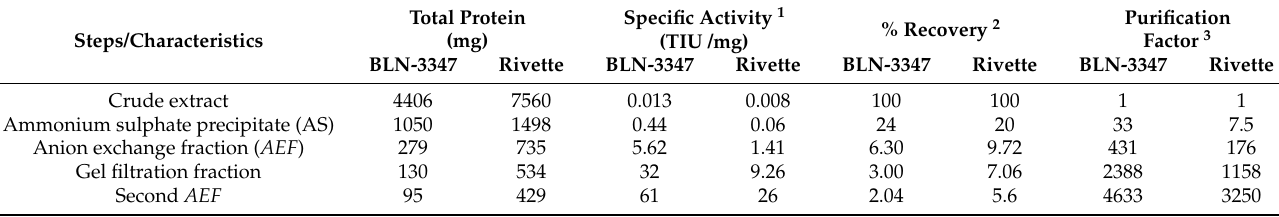
Table 1. Trypsin inhibitor (TIU) activity, total protein, percent protein recovery, and purification factor at each purification step for protease inhibitors from defatted canola